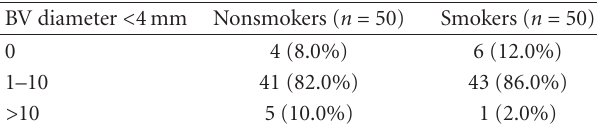
Table 11: Comparison of BV diameter < 4 between nonsmokers and smokers.